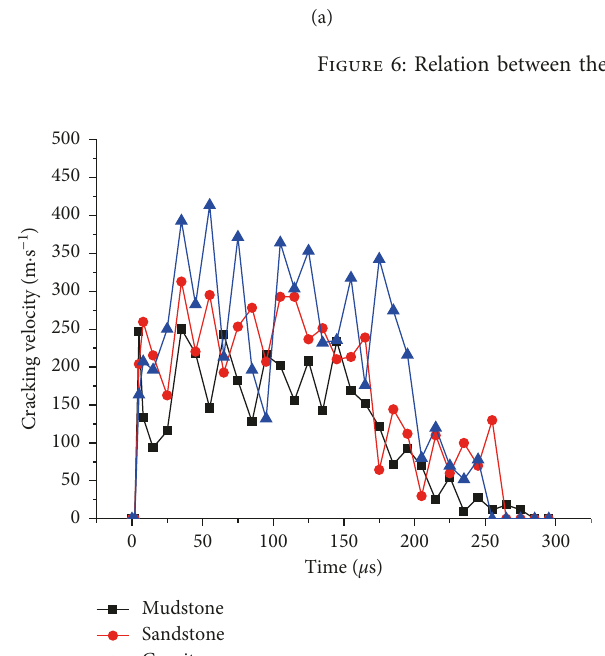
Figure 6: Relation between the primary cracking length and time.